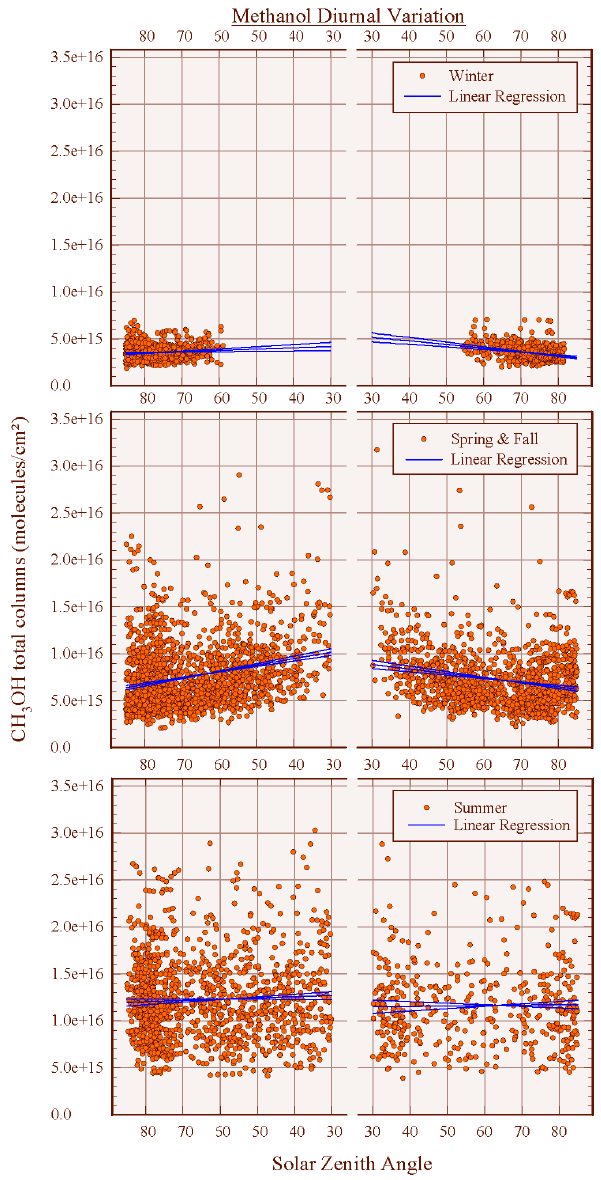
Figure 5. Methanol diurnal variation. Total columns versus the so- lar zenith angle for winter, summer and the rest of the year. Blue lines represent linear regressions and their corresponding standard deviation (1 σ